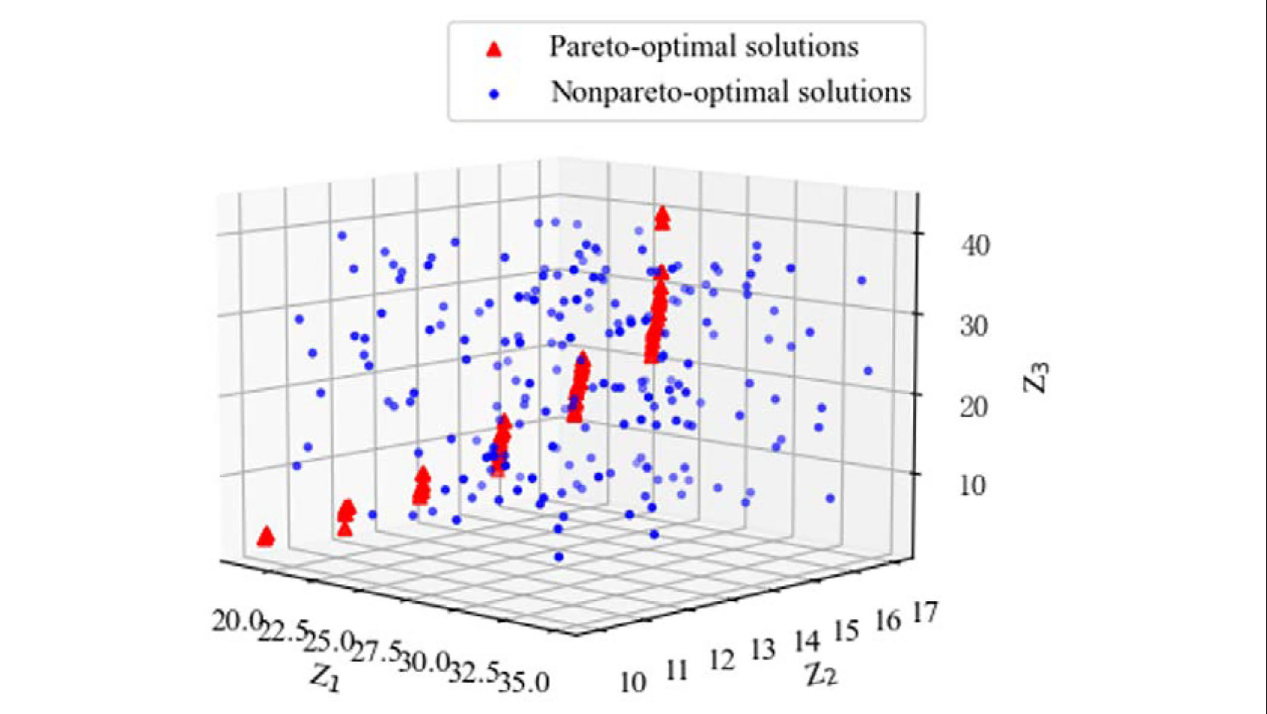
FIGURE2 Feasible solution of doctor-patient bilateral matching decision model.